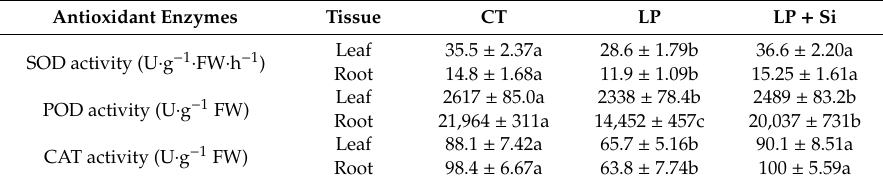
Table 3. E ff ect of exogenous silicon on activity of antioxidant enzymes in tomato plants under deficit phosphorus